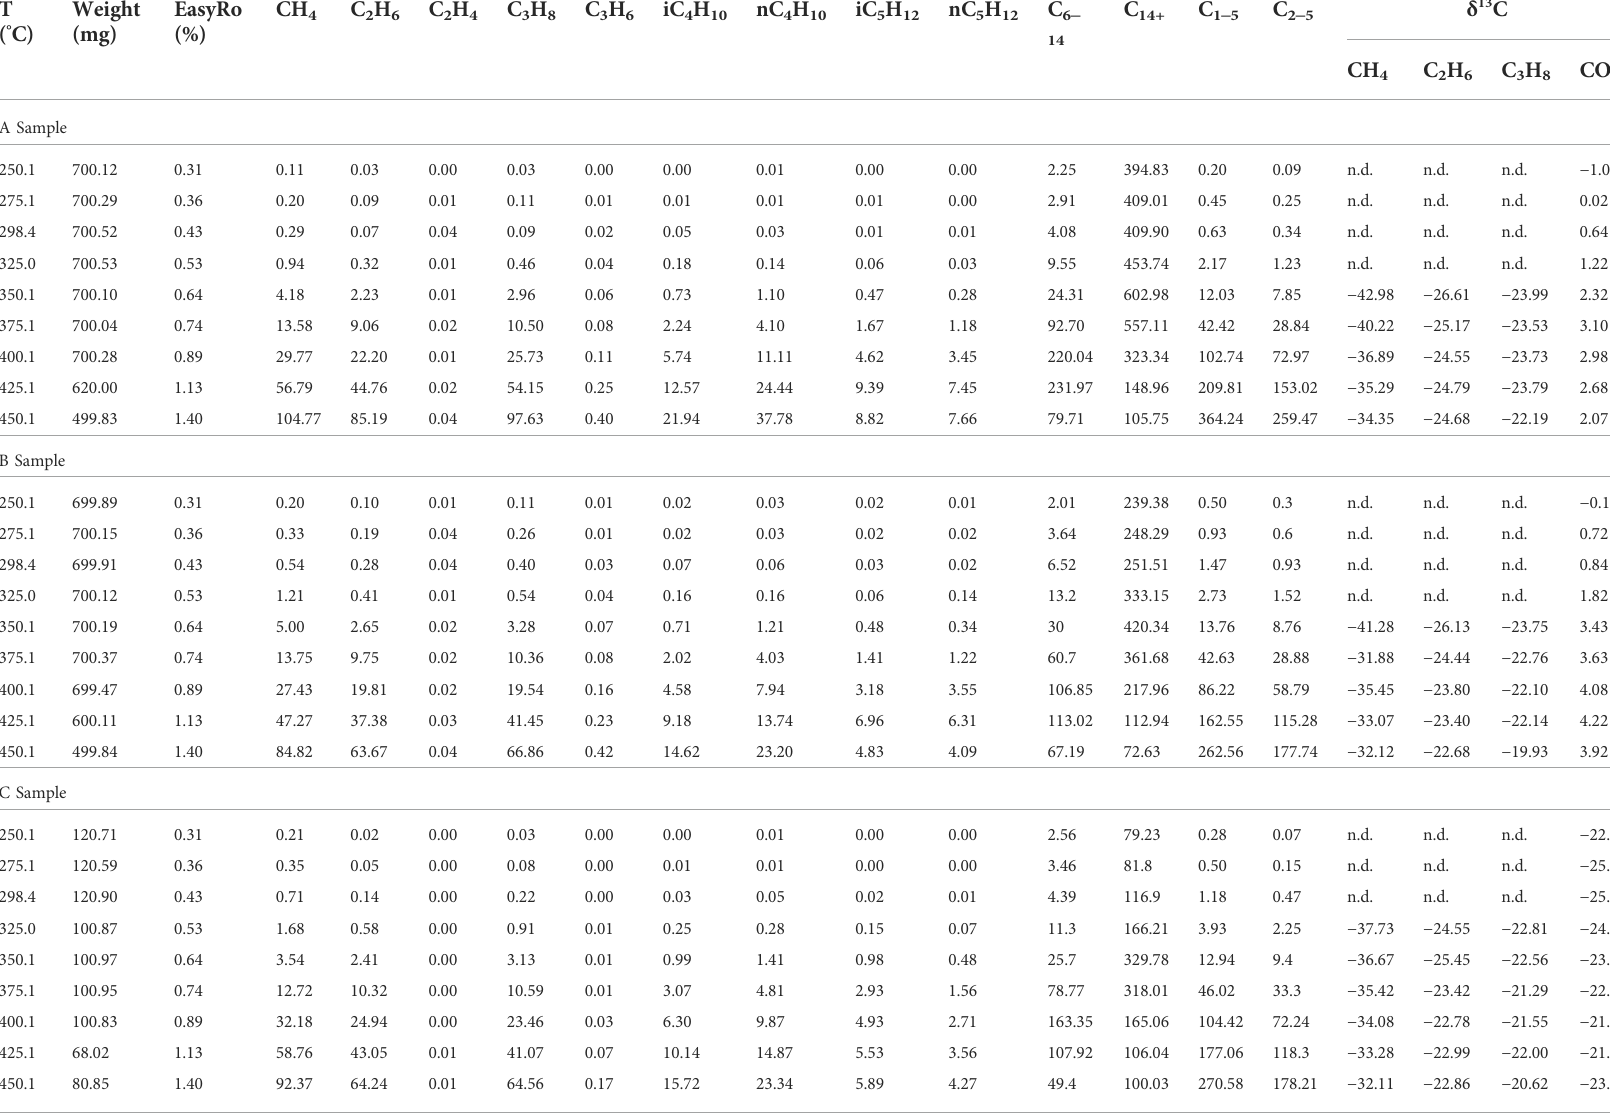
TABLE 3 Hydrocarbon yields (mg/gTOC) and stable carbon isotope compositions ( ‰ ) for the A, B, and C series samples at different temperatures. T Weight ( ° C) (mg)